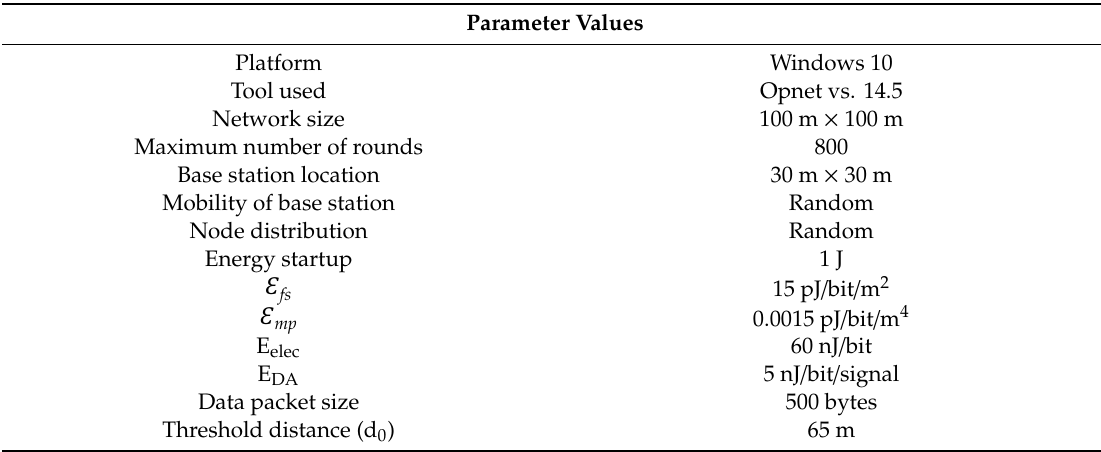
Table 1. Network parameters. Table 1. Network